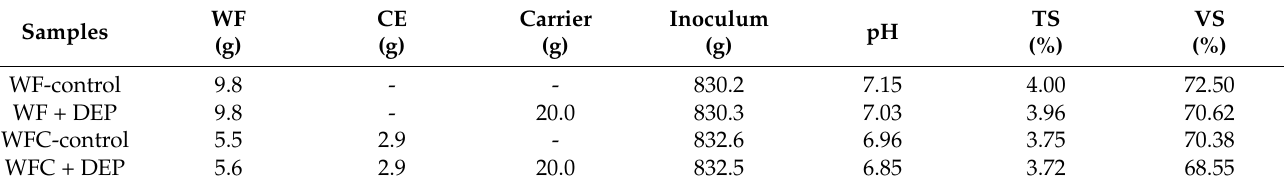
Table 1. Composition and parameters of the substrate/inoculum